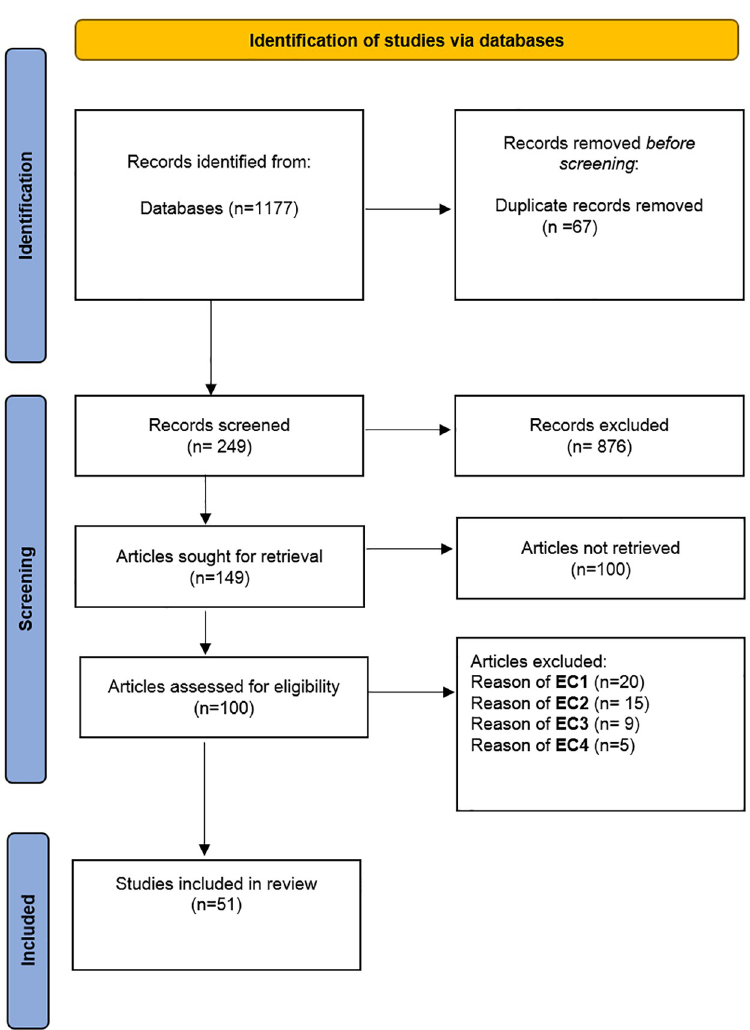
Fig 1. PRISMA flow chart-based studies selection